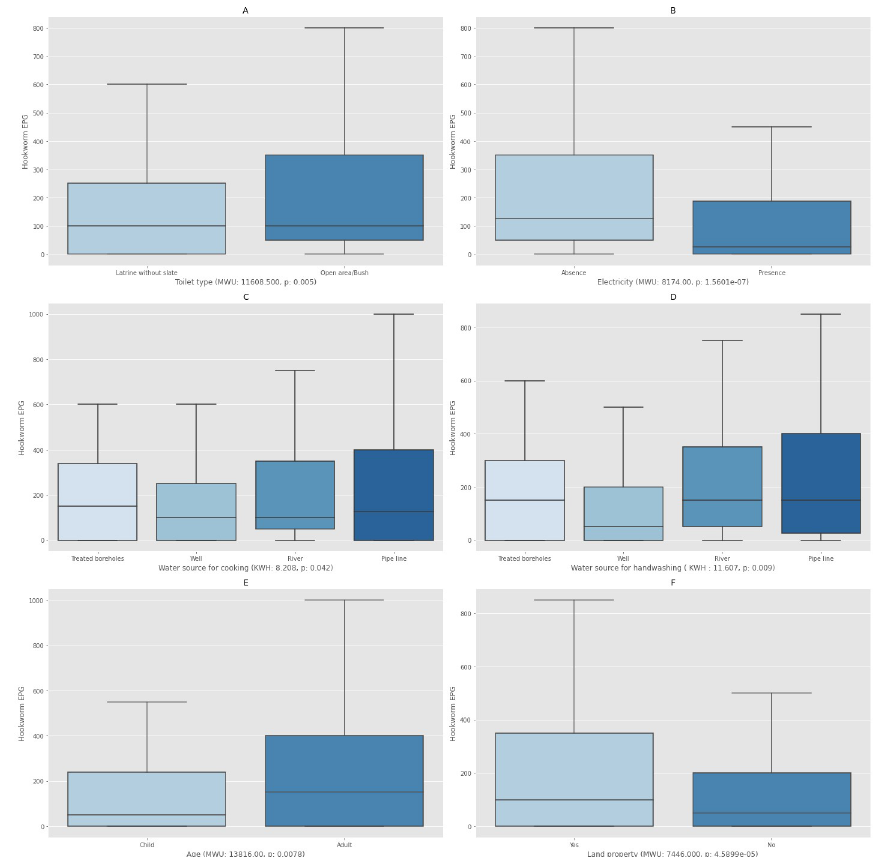
Fig 5. Boxplots showing the association between the individual number of eggs per gram of feces (EPG) and characteristics of the households. A. Toilet Type. B. Presence/absence of electricity. C. Water source for cooking. D. Water source for handwashing. E. Age (Child refers to all those under 14 and Adult refers to all those 15 or older). F. Land property. MWU: Mann-Whitney U, KWH: Kruskal-Wallis H, p: significance test (p < 0.05).